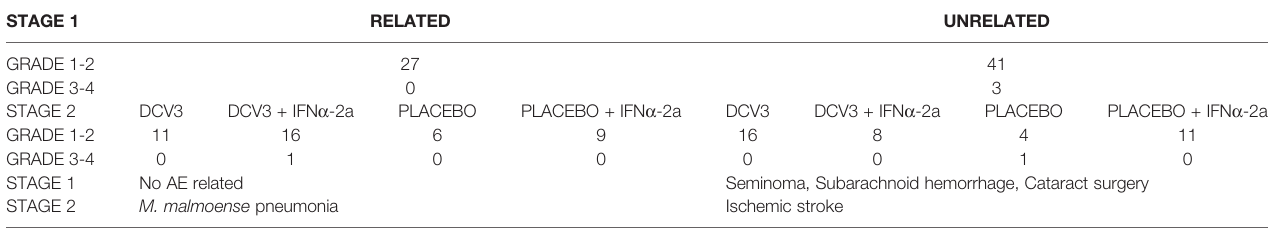
TABLE 2 | Adverse events represented in two stages: Stage 1 before vaccination (w − 52 – w − 1), and Stage 2 during vaccination and until the end of study (w0 – w28) divided by severity and its relation to the interventions. STAGE